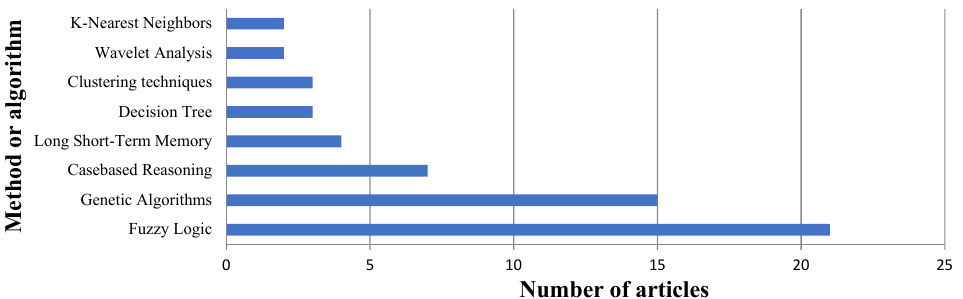
Figure 5. Methods/algorithms integrated with ANN in selected articles.